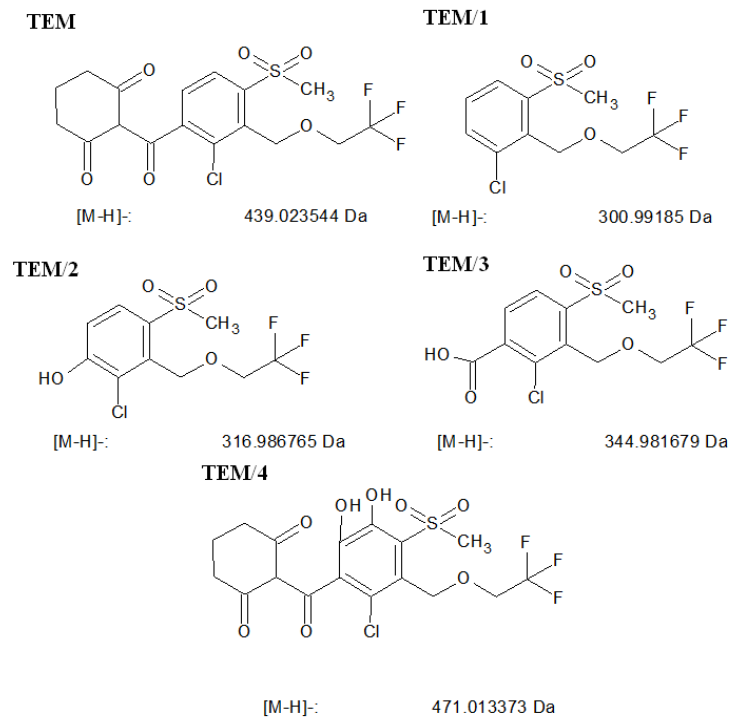
Figure 17. The structure of TEM, and the suggested structure and calculated masses of the formed ions of the detected stable products. ions of the detected stable products.